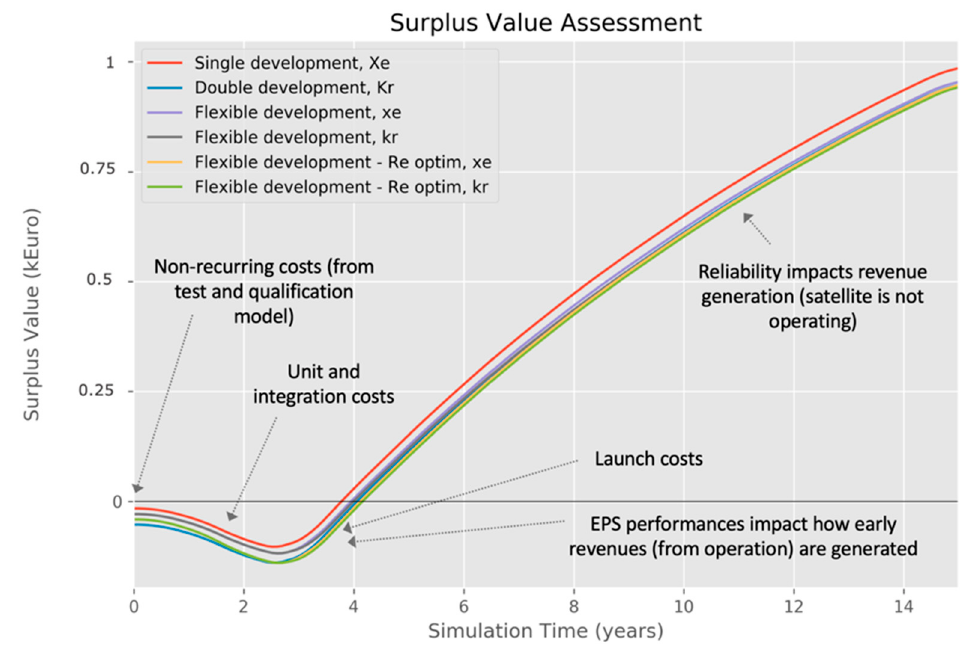
Figure 5. Surplus value (SV) for the different options, considering Market 1. The data regarding surplus value have been normalized to preserve company sensitive information.